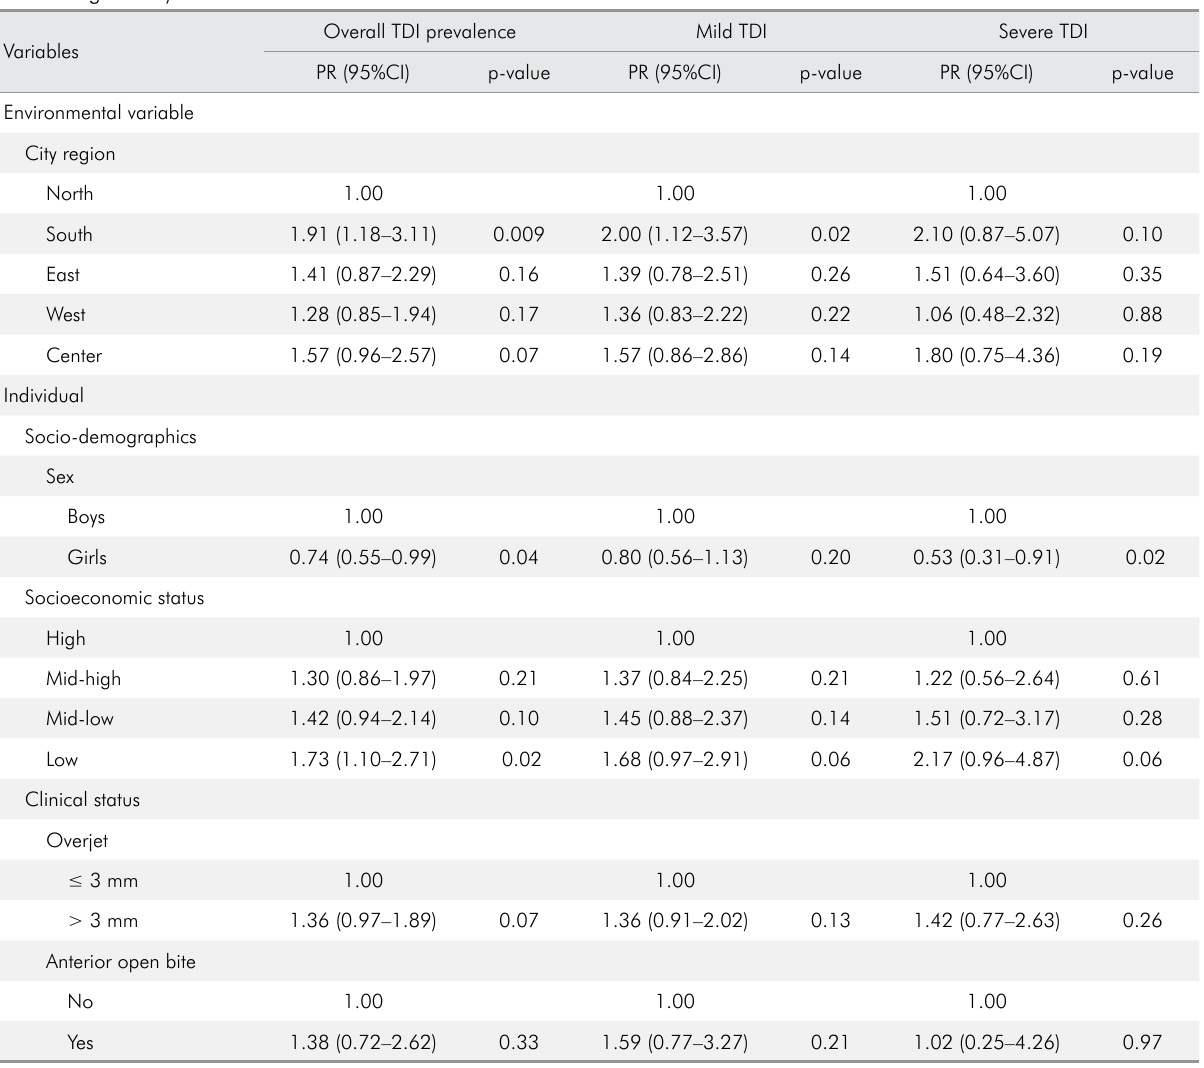
Table 2. Adjusted association between environmental and individual variables with prevalence and severity of TDI (multilevel Poisson regression).